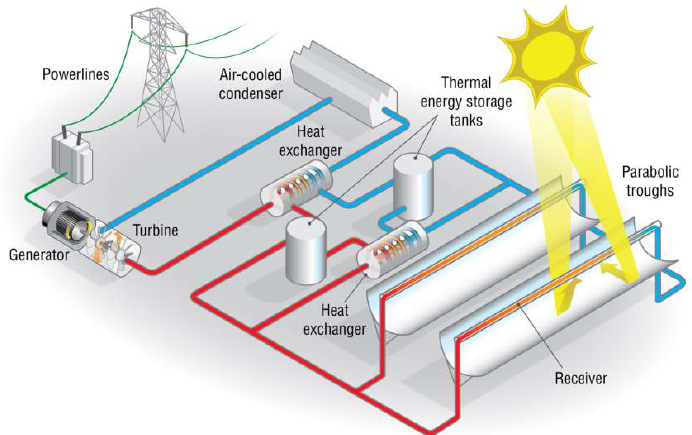
Figure 1. System Advisor Model (SAM) sketch of a parabolic trough plant. Credit NREL/SAM.